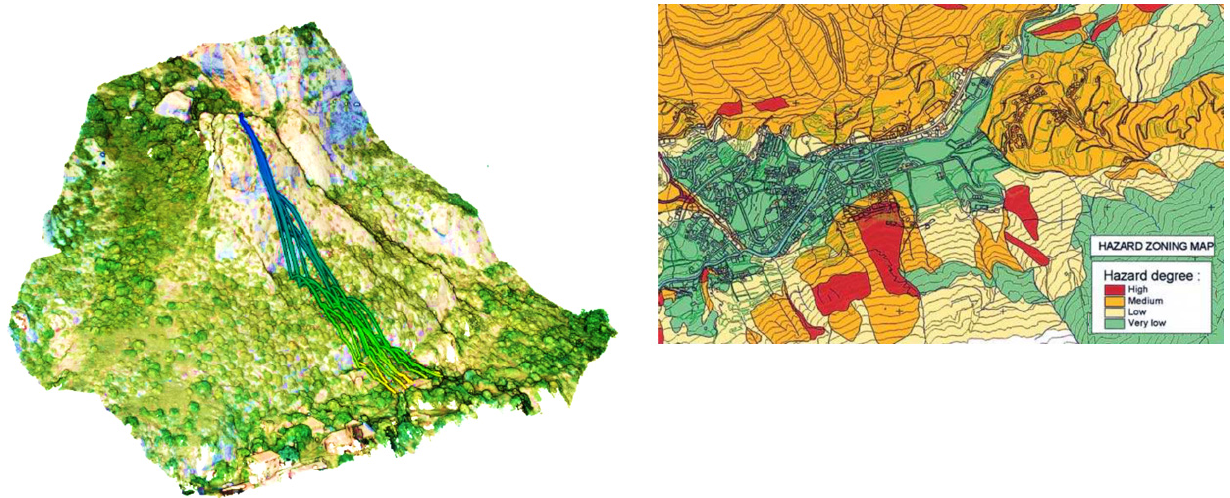
Figure 17. Comparison between the geovisualization of rockfall simulation results in 3D with MR ( left ) and a 2D hazard map of a typical risk assessment study ( right ). The first one is optimal for the full and effective communication of the risk to the community, especially to non-expert members (picture courtesy of ICGC).